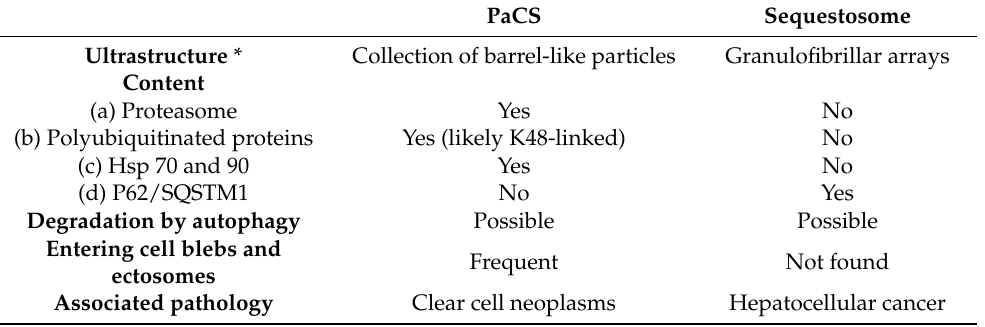
Table 1. Comparison of PaCS and sequestosome